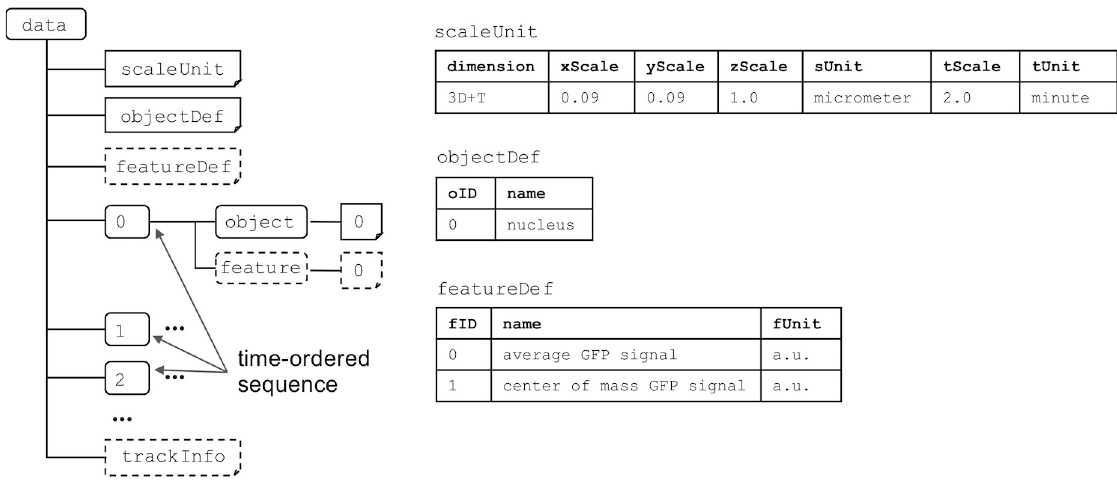
Fig 1. Outline of the BD5 data format. The data group includes scaleUnit , objectDef , featureDef , and trackInfo datasets; each data group is numbered to correspond to the index number of the time-ordered sequence. Each numbered group has spatial information about biological objects and numerical information about features related to the objects. Solid and dashed boxes represent the required and optional elements, respectively.